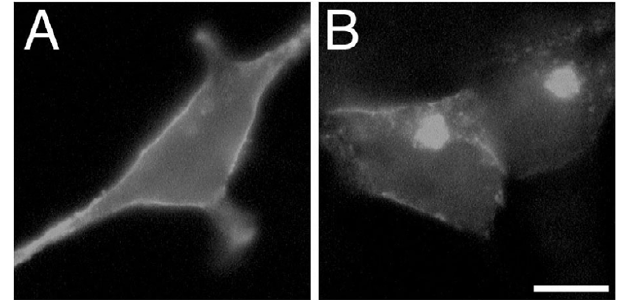
Figure 9 and s α localization when co- Effect of ALLN on α i2 i2 expressed with βγ Expression vectors encoding α i2 (A) or s α i2 (B) were transfected together with expression vectors for β 1 and γ 2 into BHK cells. 48 h after transfections cells were incubated in the presence of 20 µ g/ml ALLN for 8 h. Cells were fixed and processed for immunofluorescence using the EE antibody followed by an Alexa 594 conjugate anti-mouse antibody. Bar, 10 µ m. Figure 10 Pulse-chase analysis of α i2 , s α i2 , and α i2 A327S Expres- sion vectors encoding α i2 , s α i2 , or α i2 A327 were transfected into COS-7 cells. 48 h after transfection, cells were incu- bated for 10 min in media containing 0.1 mCi/ml 35 S Express protein labeling mix. Cells were washed, and incubated in regular media for the indicated times (chase). Cells were